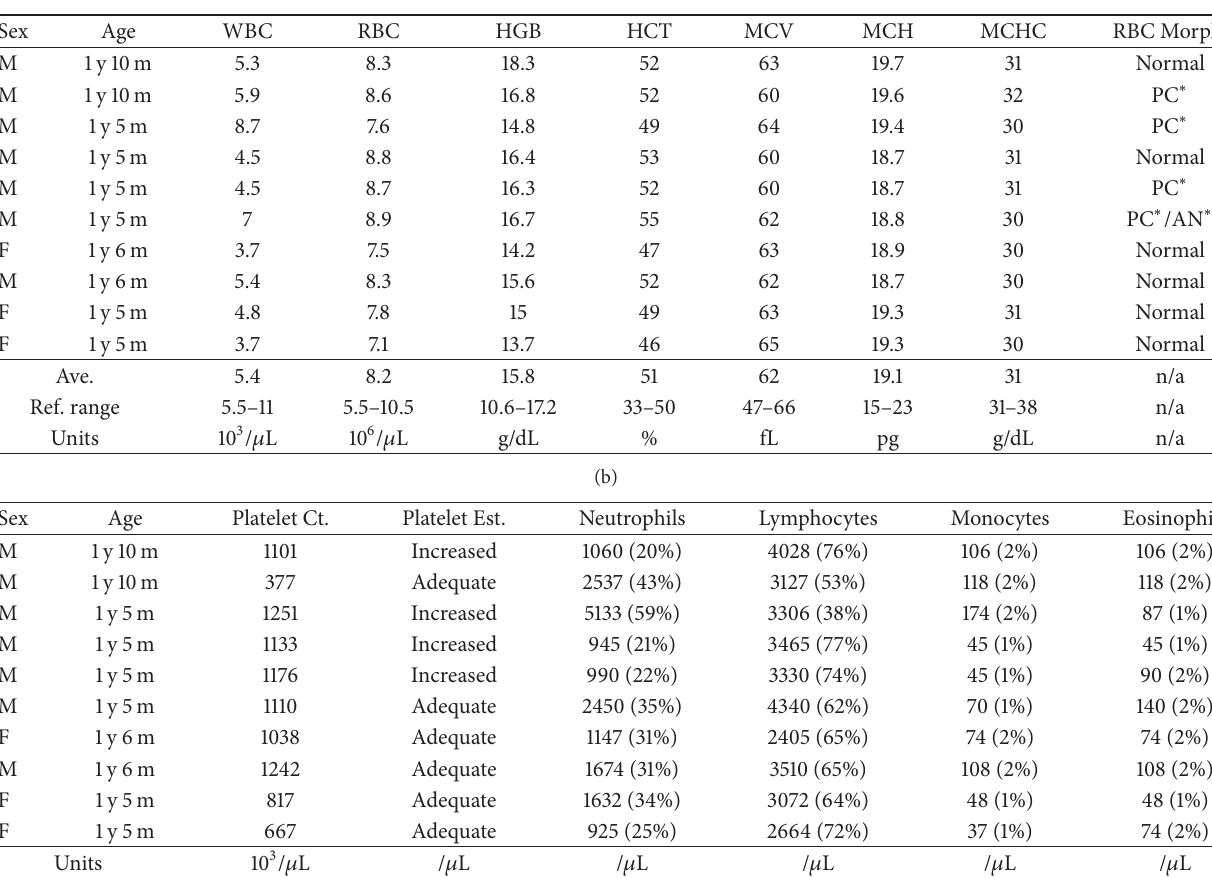
Table 1: Summary of the blood work performed on the iPSC-RPE injected animals. One-year- and 10-month-old rats are listed as 1y 10m. ∗ Slight or moderate. White blood cell count (WBC), red blood cell count (RBC), HGB (hemoglobin), hemocrit (HCT), mean corpuscle volume (MCV), mean corpuscle hemoglobin (MCH), mean corpuscle hemoglobin concentration (MCHC), red blood cell morphology (RBC Morph.), polychromasia (PC), anisocytosis (AN), reference range (Ref. range), platelet counts (Platelet Ct.), and platelet estimates (Platelet Est.).